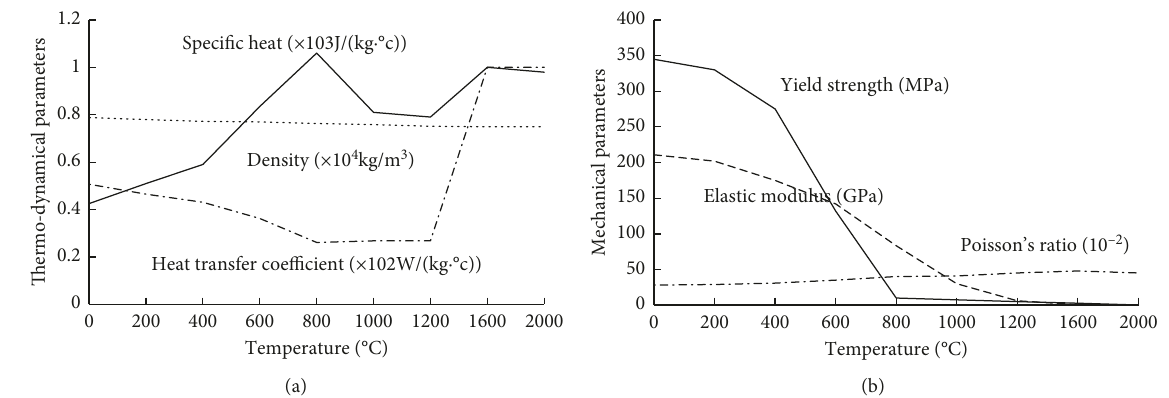
Figure 13: Thermal-dynamical and mechanical parameters of Q345 steel in welding process analysis. (a) Thermodynamical parameters. (b) Mechanical